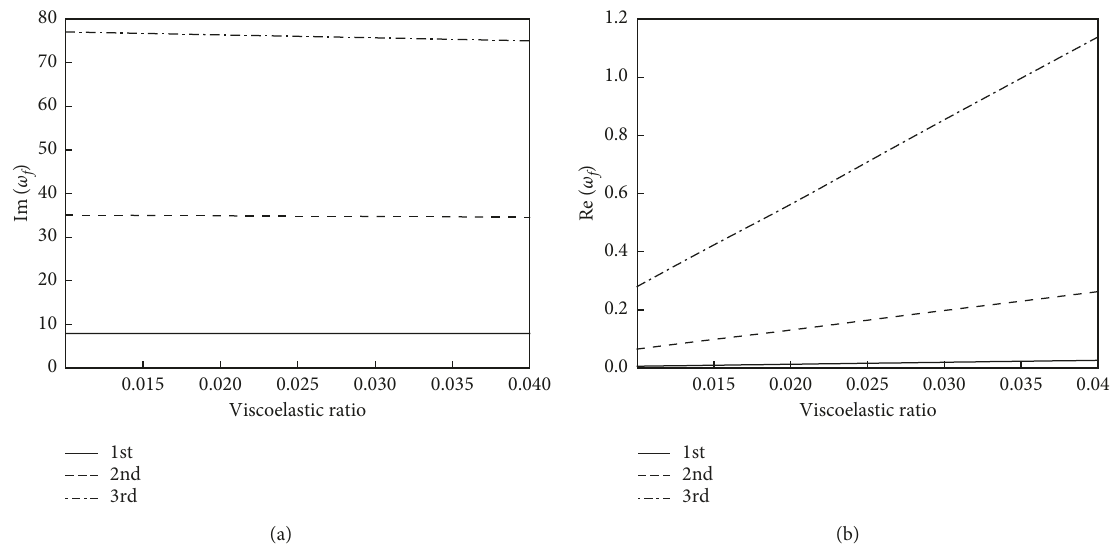
Figure 5: Variation curves of complex frequency of the system with viscoelastic ratio at r